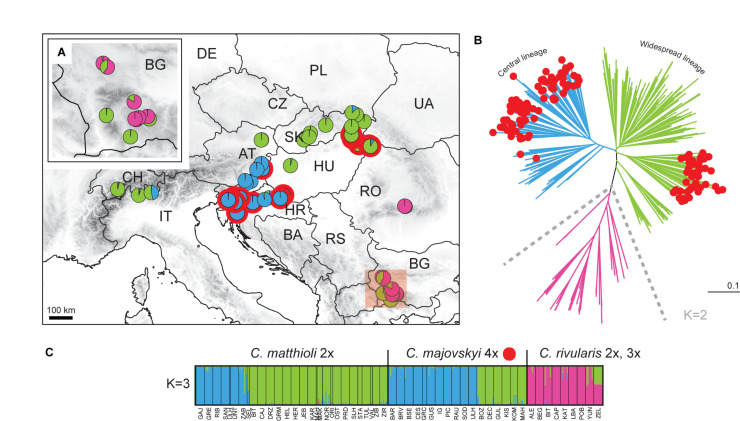
Genetic structure of Cardamine matthioli, C. majovskyi, and C. rivularis inferred from microsatellite data analyses of the MajMatRiv Matrix. (A) Distribution of the sample sites. Different colors indicate the population assignment to the three genetic clusters as inferred from STRUCTURE analyses. Circles with red outlines represent populations of C. majovskyi.
(B) Neighbor-joining tree diagram, calculated using Lynch distances. Red dots highlight individuals of C. majovskyi. (C) Bayesian model-based clustering (STRUCTURE) at K = 3. Coloring of vertical bars indicates each individual’s proportional cluster assignment: blue: Central lineage; green: Widespread lineage; purple: C. rivularis. For locality codes see Supplementary Data 1.